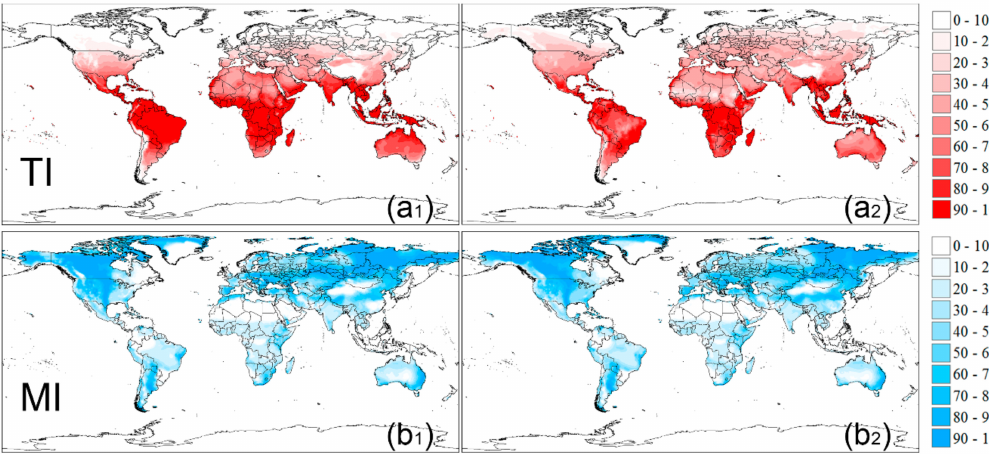
Figure 9. Global map of monthly growth indices for C. vesuviana . ( a ) Map of the monthly temperature index (TI), and ( b ) map of the monthly moisture index (MI). Subscript (1) indicates historical climatic conditions and subscript (2) indicates future climatic conditions. Depth of color indicates the weight of each value: the darker the color, the larger the